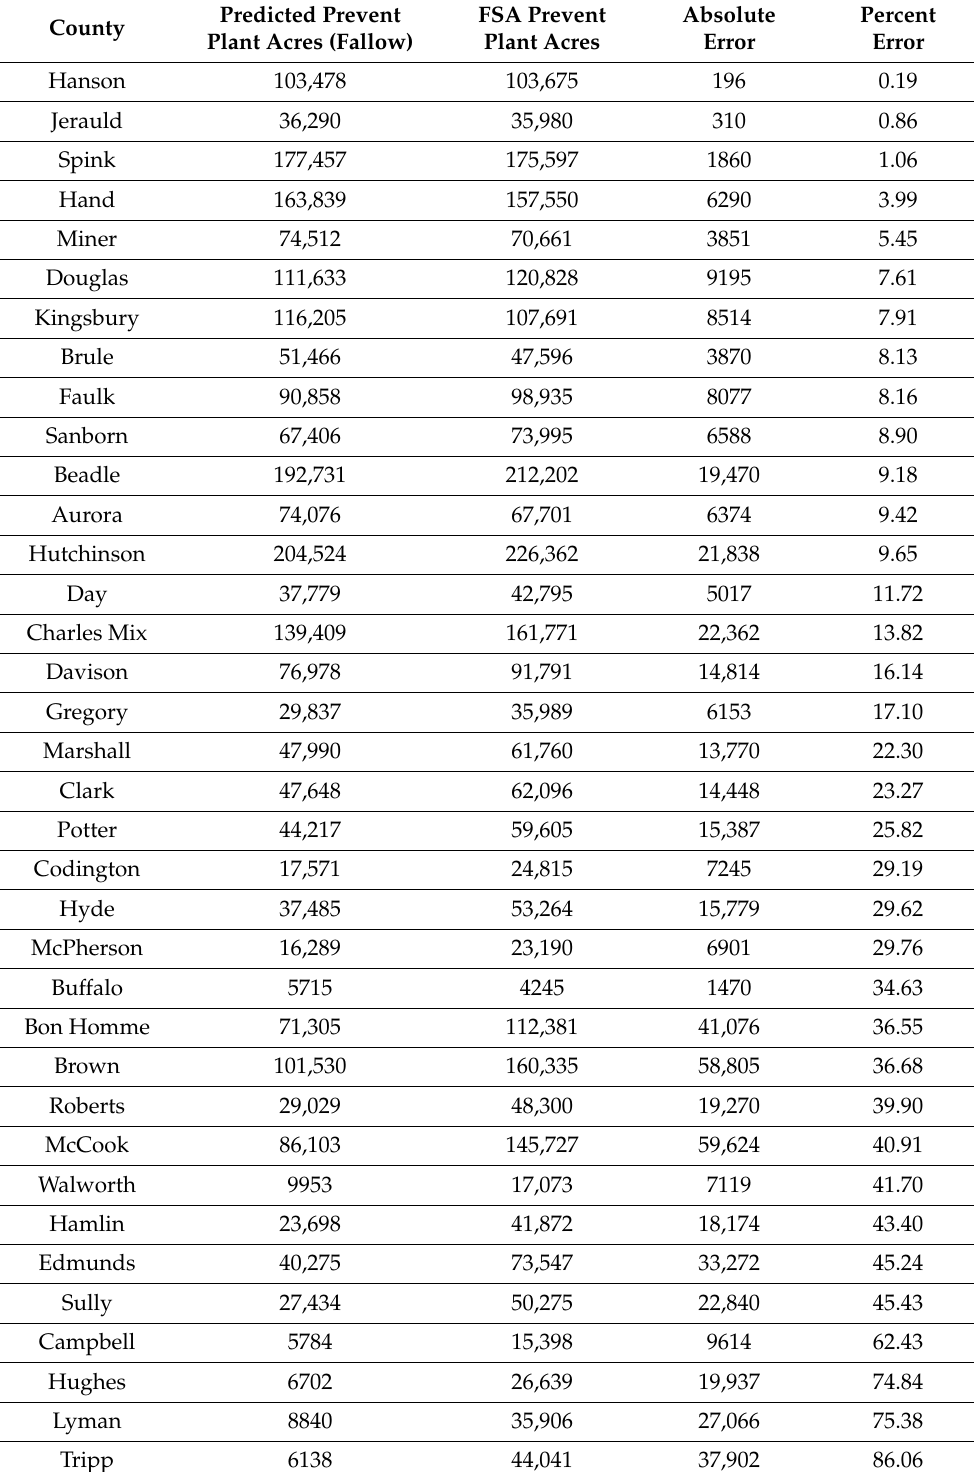
Table A1. A comparison of observed and predicted prevent plant acres sorted by percent